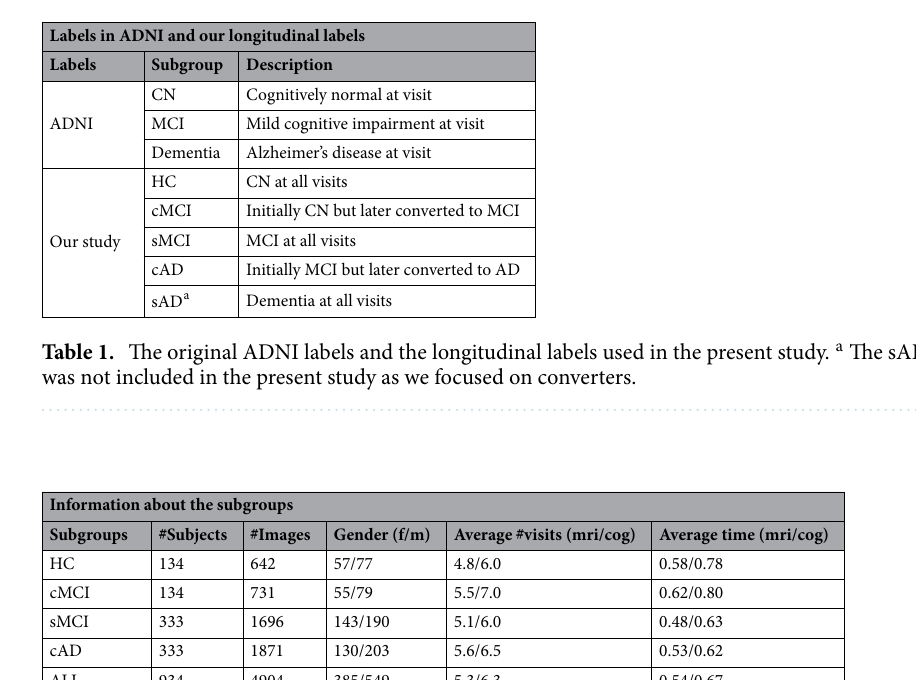
Information about the subgroups Table 2. Total number of subjects, T1-weighted MR images, and gender distribution within each of the four subgroups. The table also shows the average number of MRI scans (mri) and cognitive tests (cog) per subject, available in each subgroup, and the average time (in years) between the MRI scans and cognitive tests per subgroup.